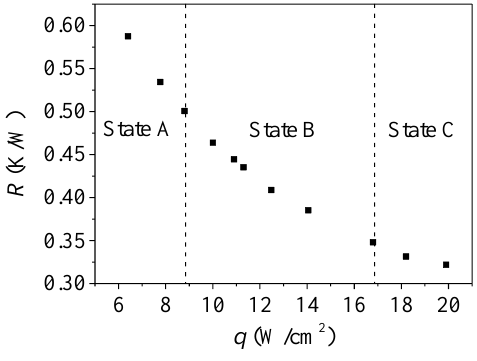
Figure 11. Effect of the heat load on total thermal resistance.